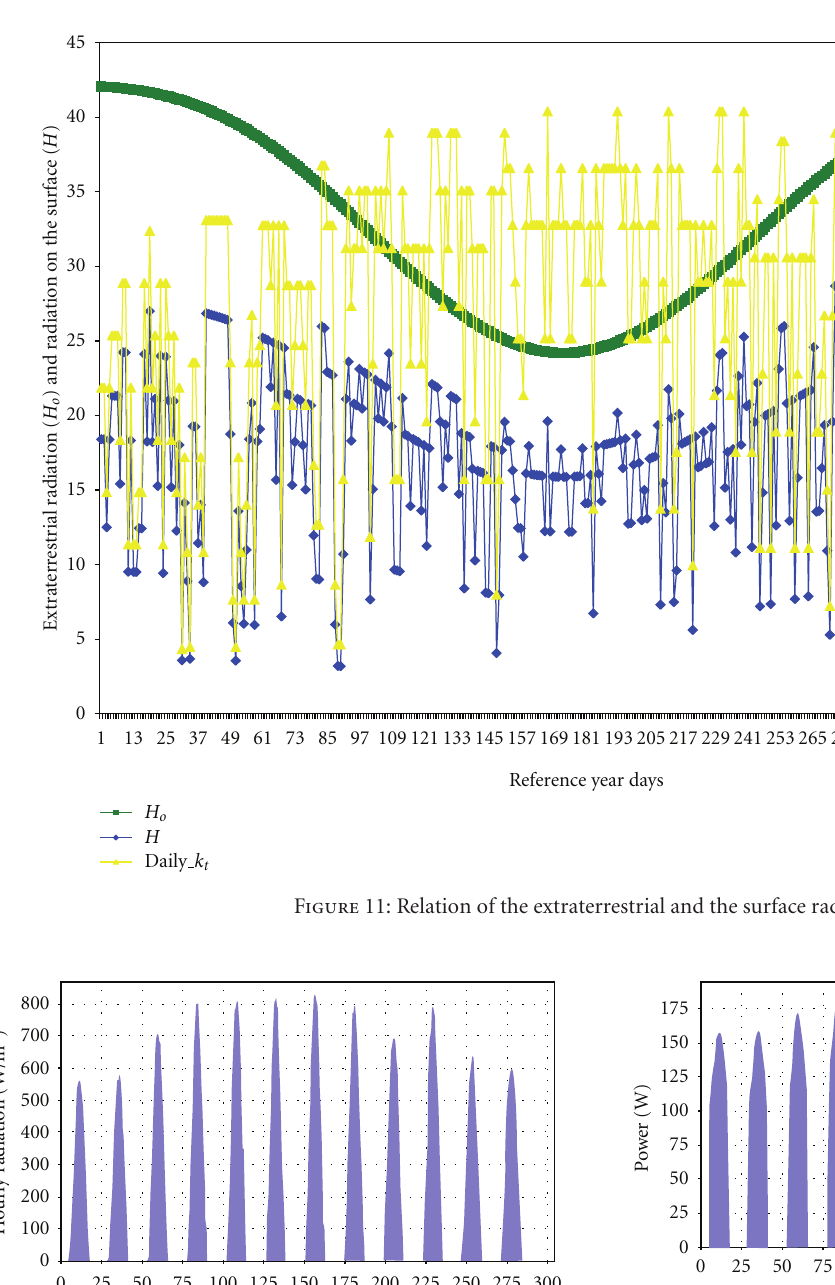
Figure 13: Monthly mean hourly power generated by the photo- voltaic modulus along the